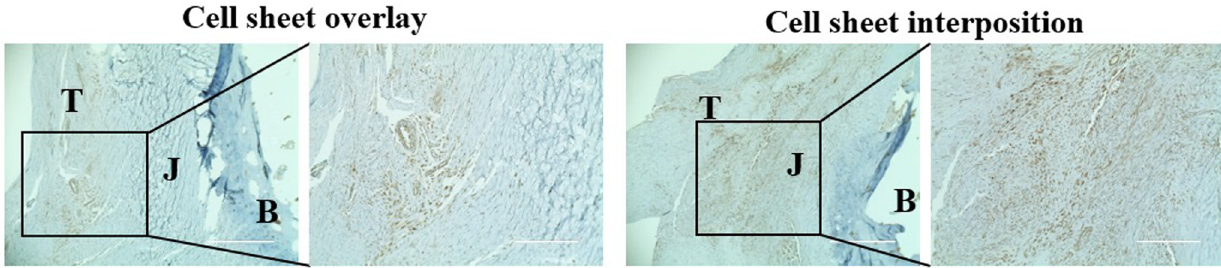
Fig 4. The confirmation of GFP expression depending on the location of the transplanted cell sheets. The cell sheets were transplanted above (left) or between (right) the tendon-to-bone junction. The GFP-tagging cells were used for the transplanted sheets, and it was confirmed two weeks after repair. GFP expression is located at the black box and shown as brown